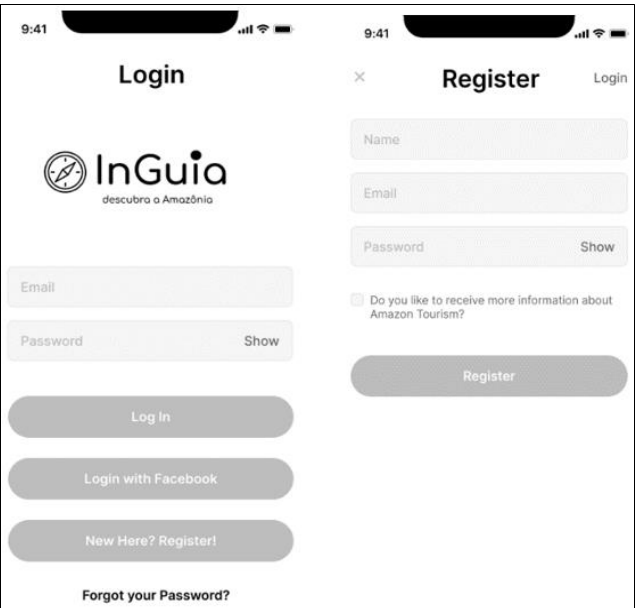
Figure 4: Login and Registration